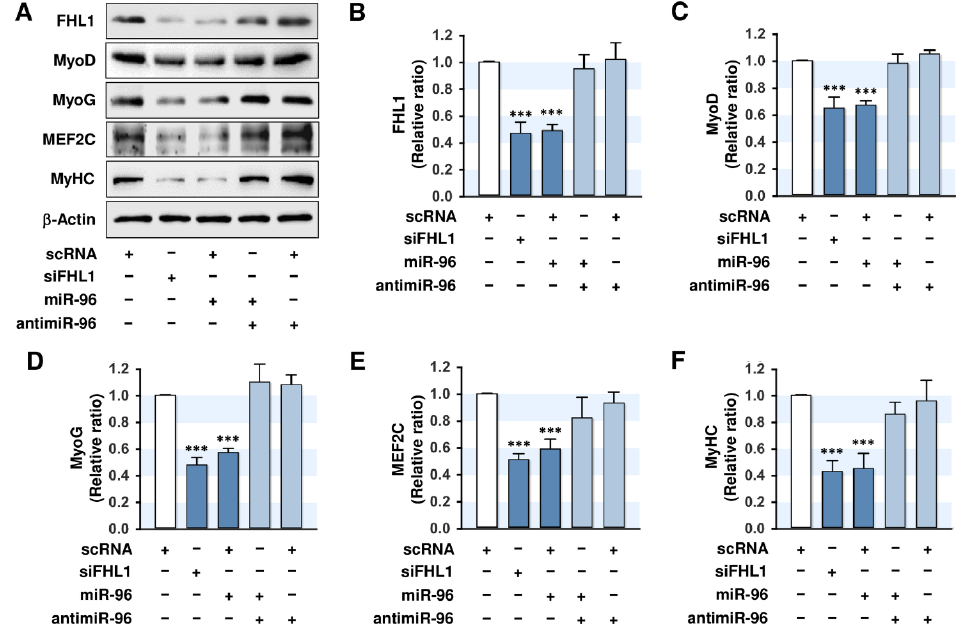
Figure 5. MiR ‐ 96 ‐ 5p suppresses the expressions of myogenic factors and FHL1. C2C12 myoblasts were transfected with 100 nM of scRNA control, siFHL1, miR ‐ 96 ‐ 5p mimic, or antimiR ‐ 96 ‐ 5p. ( A ) Representative immunoblots obtained after differentiation for three days. ( B ) Quantitative analysis of FHL1 expression. ( C – F ) Quantitative analysis of MyoD, MyoD, MEF2C, and MyHC expressions. Expression levels were normalized vs. β‐ Actin. The values are expressed as the relative ratio, where the intensity of normalized scRNA control was set to one. Results are expressed as means ± SEMs ( n > 3). ***, p < 0.001 vs. scRNA.